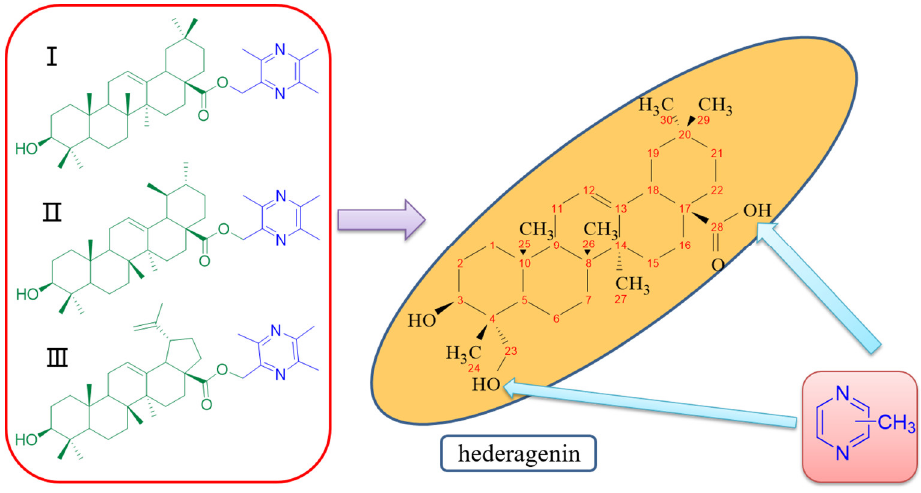
Figure 1. Structural modification of hederagenin ( He ).